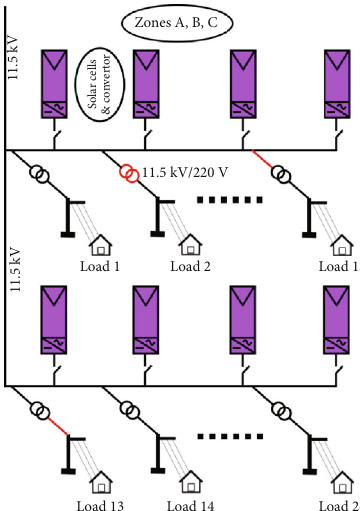
Figure 2: DG in di ff erent zones with overloaded transformers and distribution